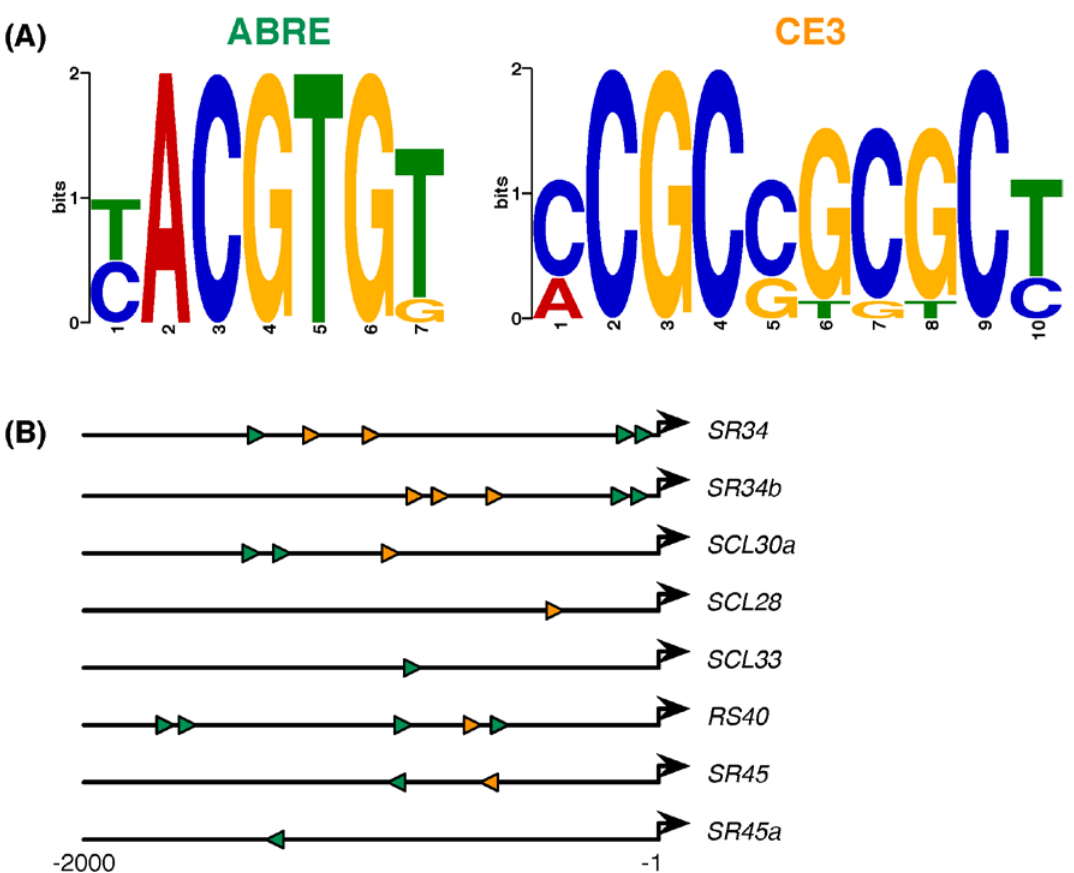
Figure 6. ABA-responsive cis -element consensus sequences and their locations/orientations in the eight SR/SR-like genes responsive to ABA and/or alterations in the ABA pathway. ( A ) The ABRE (7 bp) and CE3 (10 bp) motif logos as generated by MEME [86] based on previously reported motifs [84]; and ( B ) Schematic representation of the relative position and orientation of ABRE (green) and CE3 (orange) elements found in the 2 kb upstream sequences of the SR or SR-like genes found to respond to any of the ABA scenarios analyzed (see Figures 2–5). The bold black arrows denote the transcription start sites. Exact coordinates of the elements are presented in Table